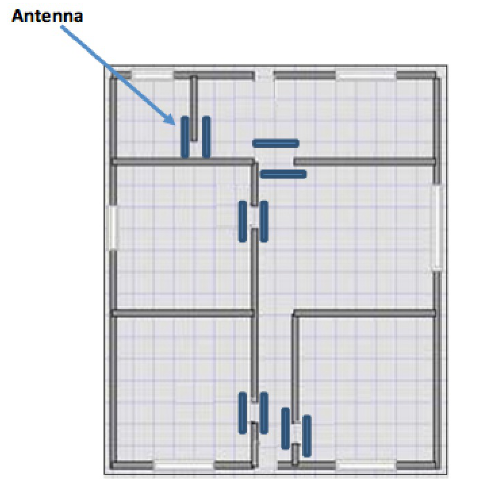
Figure 12. Position of antennas in the